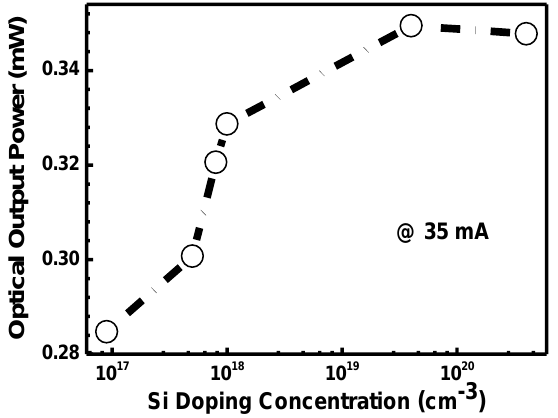
Figure 3. Optical output power for DUV LED structures with different Si doping concentrations in the X region. Data are collected at the injection current level of 35 mA.